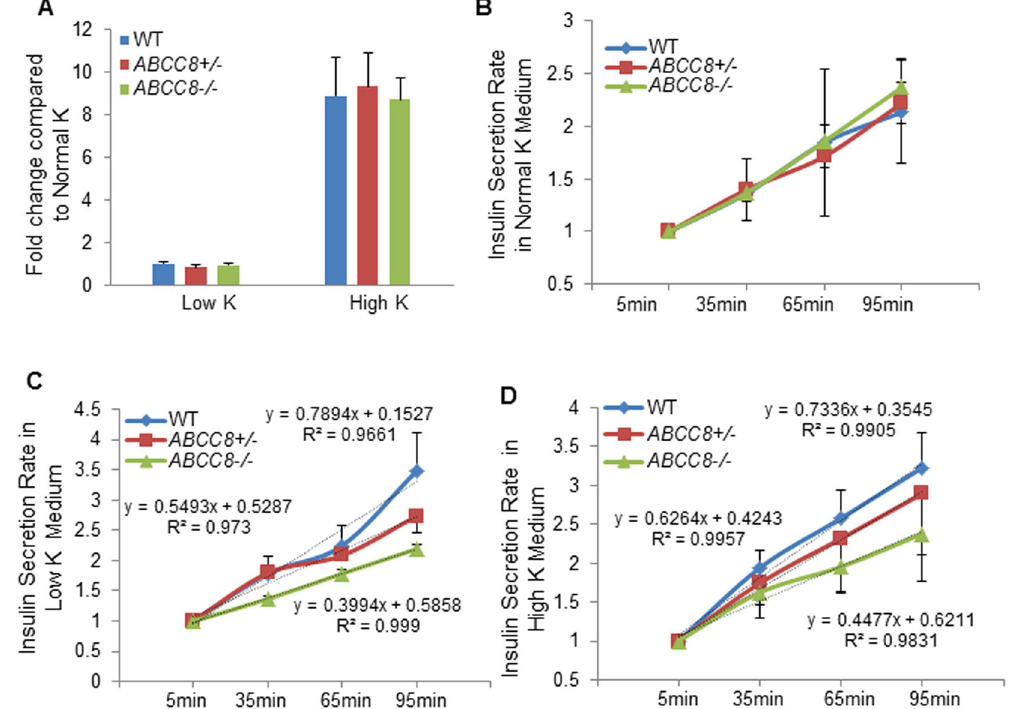
Figure 2. ABCC8 mutation decreased the insulin secretion rate in low and high potassium medium. ( A ) The fold change of C-peptide content after incubation in low K + and high K + medium compared with normal K + medium. Wild-type, heterozygous mutated and homozygous mutated cells exhibited similar changes. ( B ) Insulin secretion rate in normal K + medium (KRBH). Wild-type and ABCC8 -deficient cells had similar secretion rates. ( C ) Insulin secretion rate in low K + medium. ABCC8 mutation decreased the insulin secretion rate in low K + medium. ( D ) Insulin secretion rate in high K + medium. ABCC8 mutation decreased the insulin secretion rate in high K +